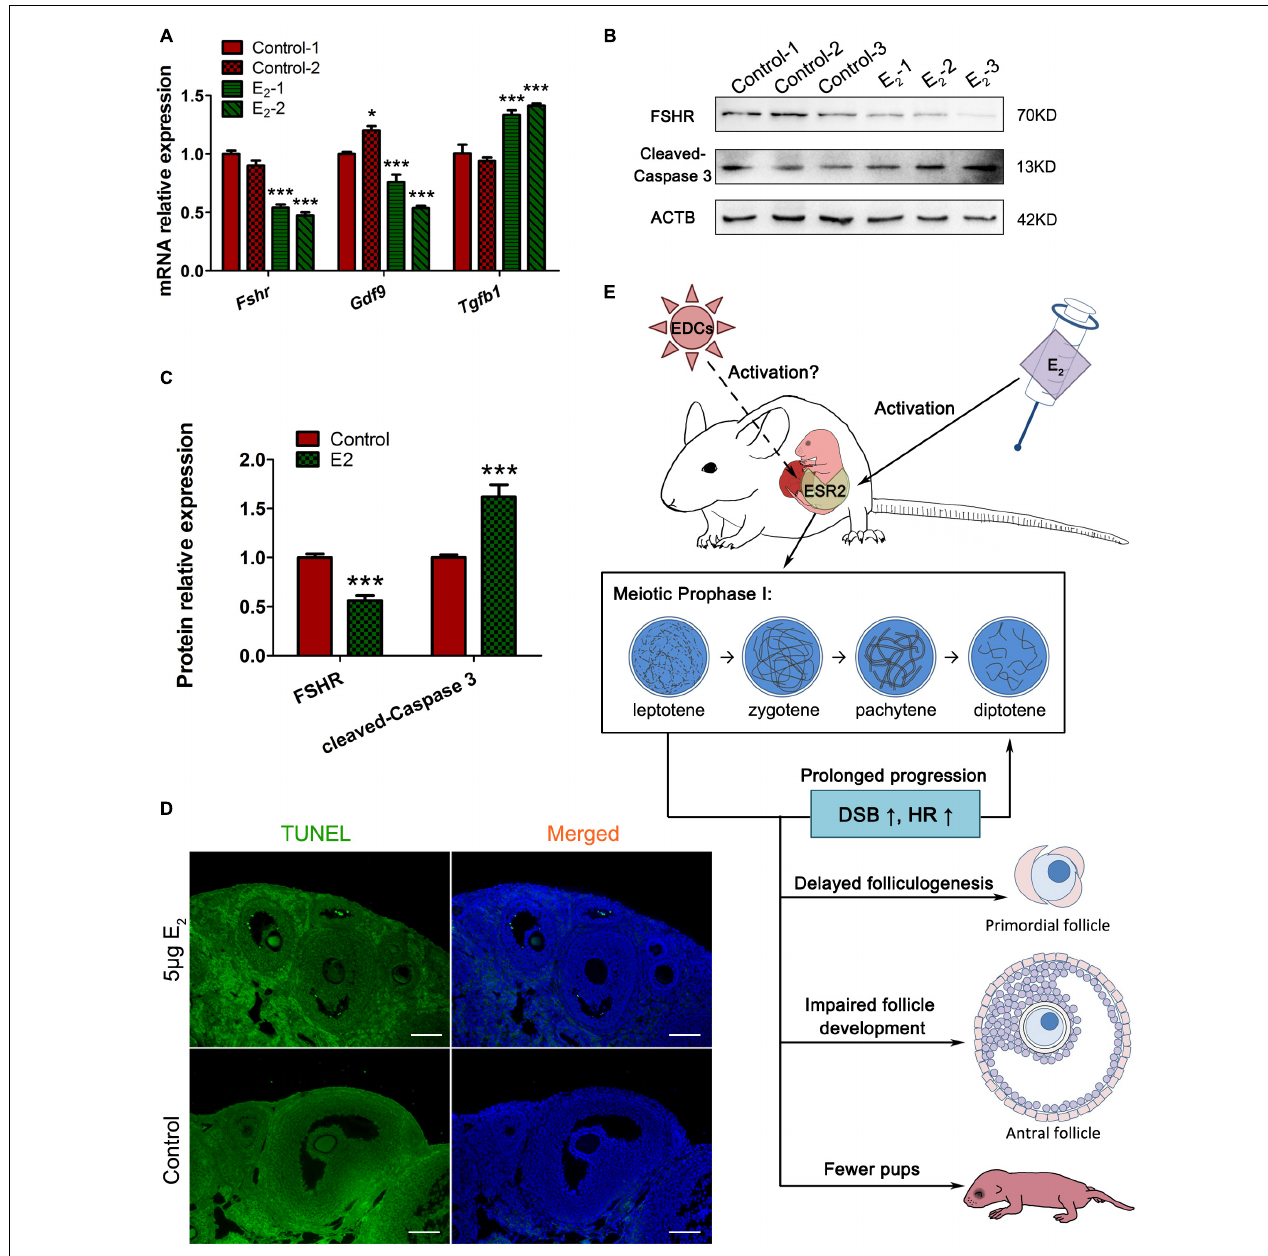
FIGURE 9 | In utero exposure of excessive E 2 damages antral follicle development. (A) The mRNA expression of key genes in antral folliculogenesis. (B,C) The protein expression of FSHR and cleaved caspase-3. (D) TUNEL assay in antral follicles. (E) Summary effects of in utero exposure of excessive E 2 on female offspring. Bar: 50 µ m. * p < 0.05, ** p < 0.01, *** p < 0.001.